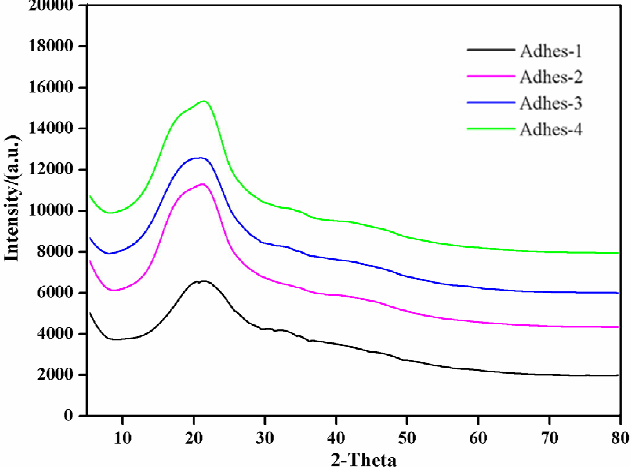
Figure 7. XRD results of curing products of Camellia oleifera cake-protein adhesives. Note: Adhes-1, the pure Camellia oleifera cake-protein adhesive; Adhes-2, Camellia oleifera cake-protein adhesive modified with DSP; Adhes-3, Camellia oleifera cake-protein adhesive modified with SPI; Adhes-4, Camellia oleifera cake-protein adhesive modified with casein.